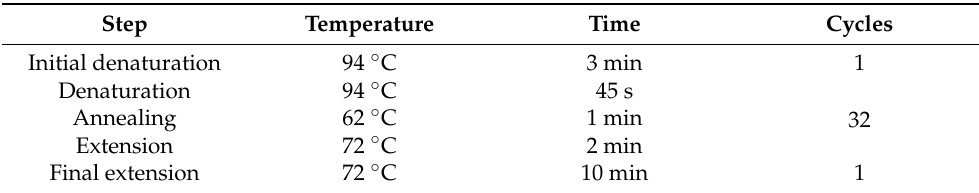
Table A3. PCR program for three-primers marker system.